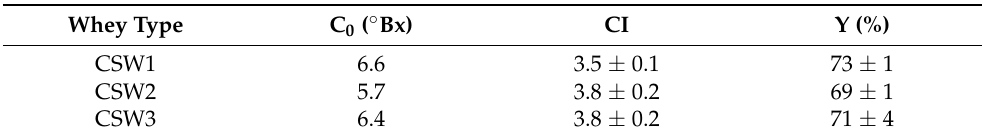
Table 4. Results of concentration index (CI) and solute yield (Y) for the three types of serum subjected to 10 kPa for 60 min.